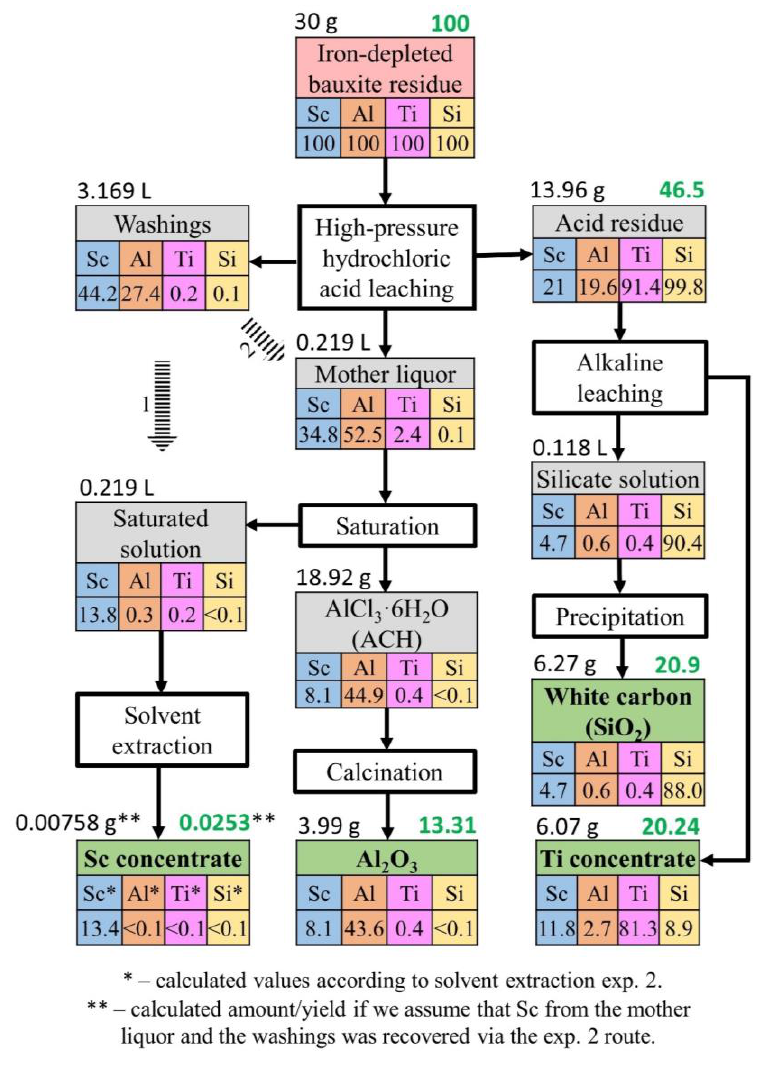
Figure 17. The laboratory-scale flowsheet with marked recovery degrees of Sc, Al, Ti, and Si into the main intermediate and final products from the IDBR sample. Mass or volume and yield (in green) are also indicated.